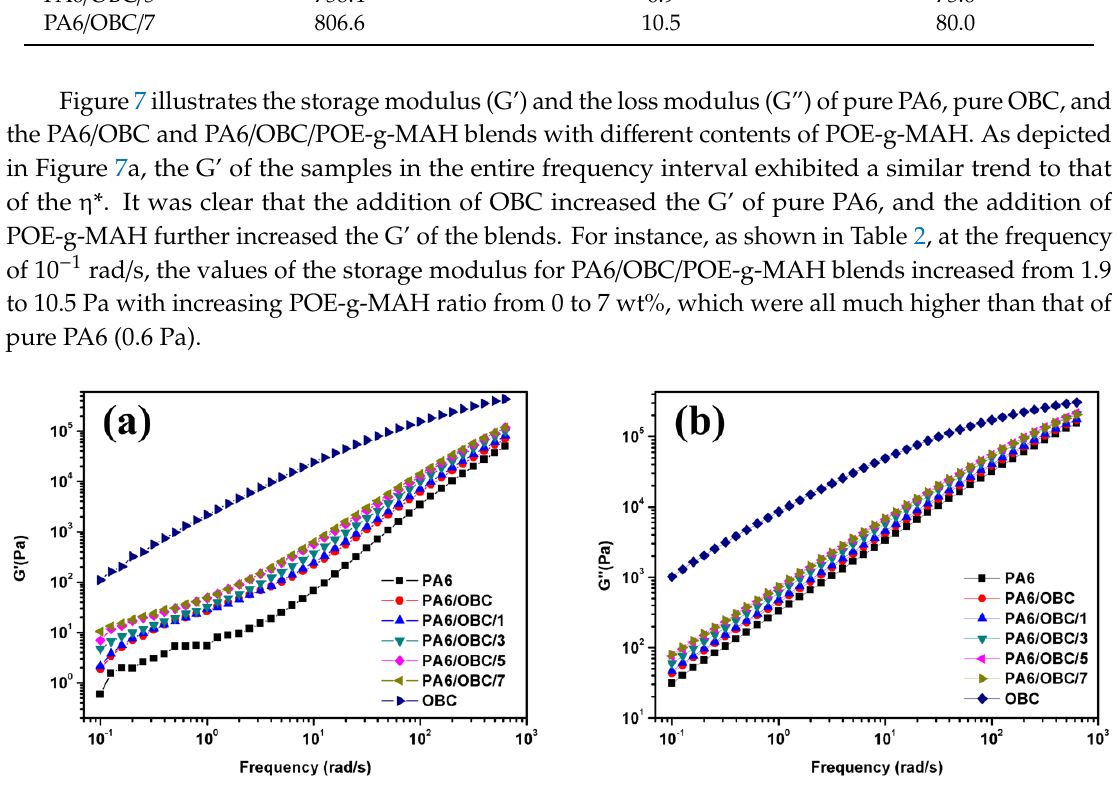
Figure 7. ( a ) Storage modulus (G’) and ( b ) loss modulus (G”) of pure PA6, pure OBC, and the PA6 /